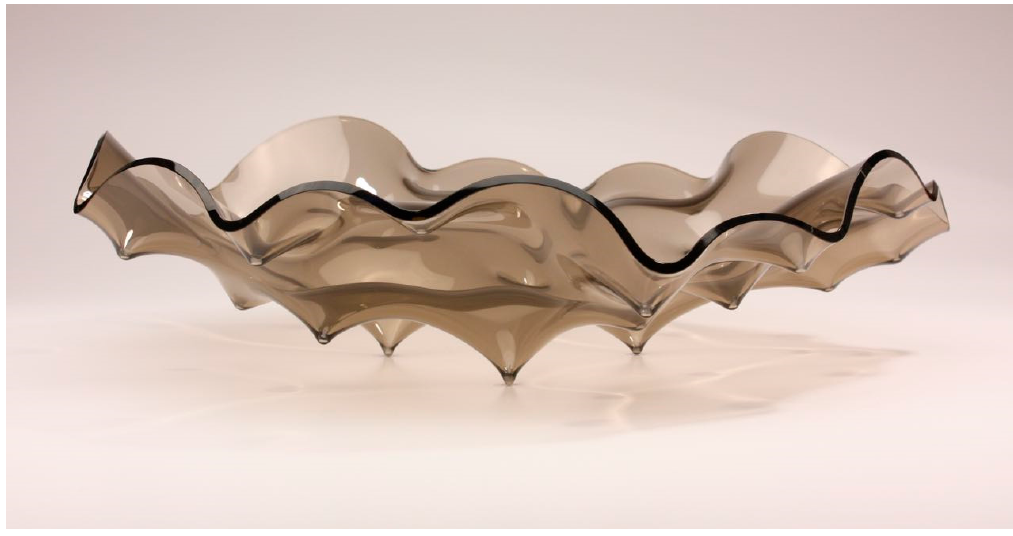
Figure 10. Bronze-coloured Pin Bowl, illustrating tripod feet, (photo: Jorgensen, T. 2013).